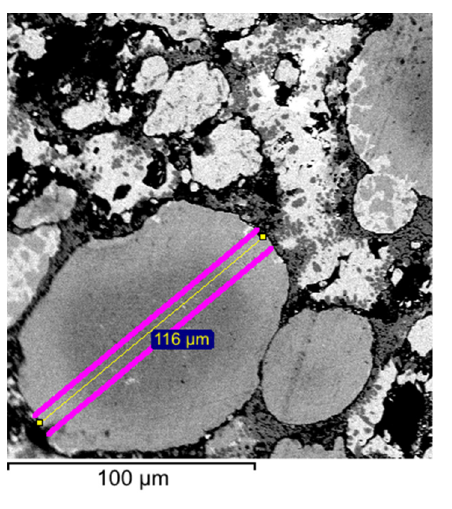
Figure 2. Structure ( a ) and tin distribution maps ( b ) for metallic binders sintered at 700–820 °C.